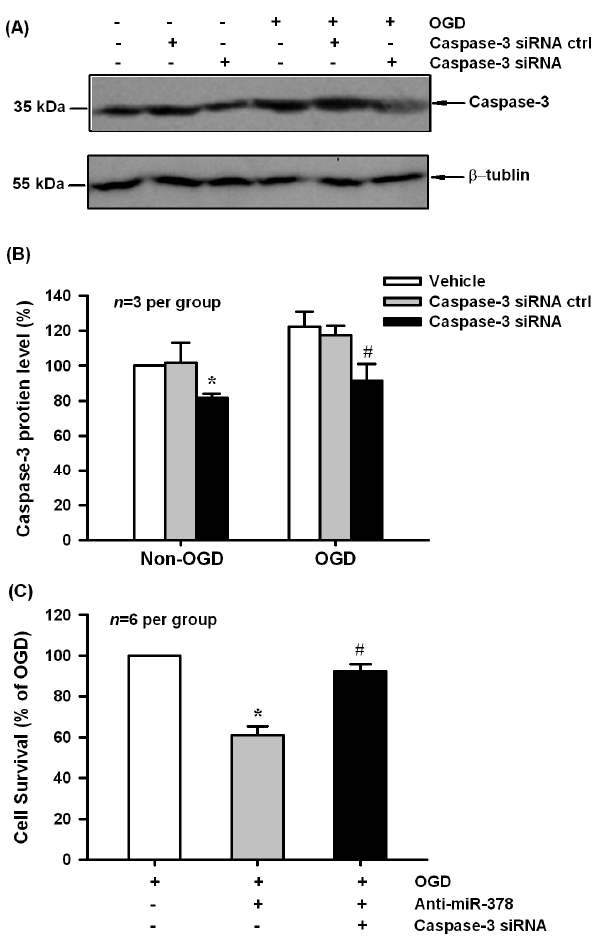
Figure 5. Caspase ‐ 3 siRNAs blocked anti ‐ miR ‐ 378 ‐ mediated neuronal injury in N2A cells. ( A , B